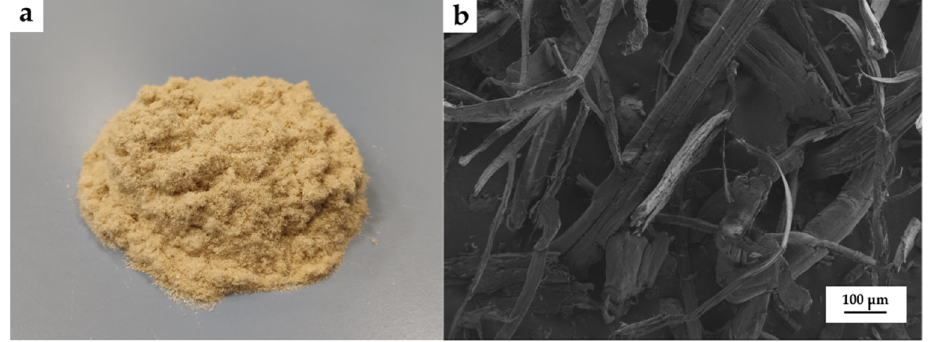
Figure 1. ( a ) Visual aspect and ( b ) field emission scanning electron microscopy (FESEM) images at 100x of Hemp fibers.